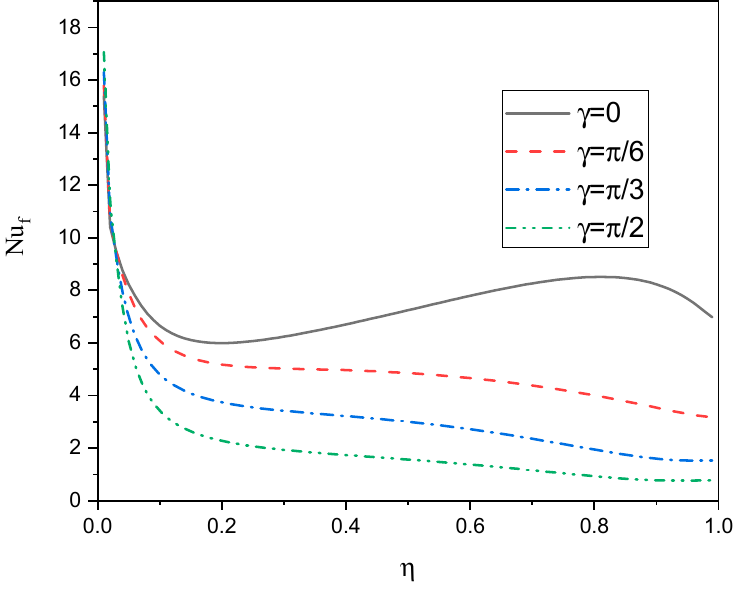
. (cid:2871) . . 3 (cid:2871)